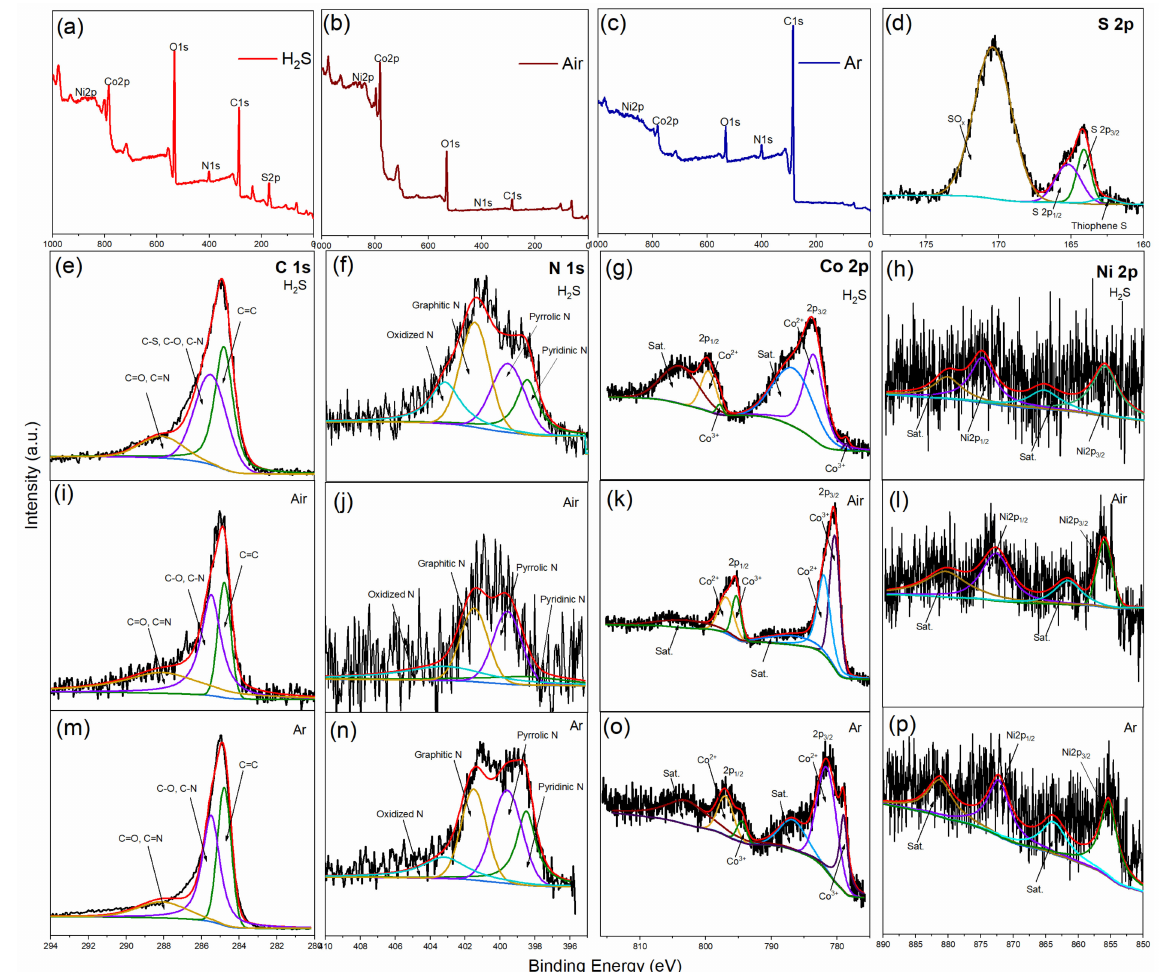
Figure 8. X-ray photoelectron spectrum of Ni 1 Co 4 -ZIFs/PAN nanofiber under different atmospheres (Ar, Air, and H 2 S); Survey spectrum ( a – c ), S 2p ( d ), C 1s ( e , i , m ), N 1s ( f , j , n ), Co 2p ( g , k , o ), and Ni 2p ( h , l , p